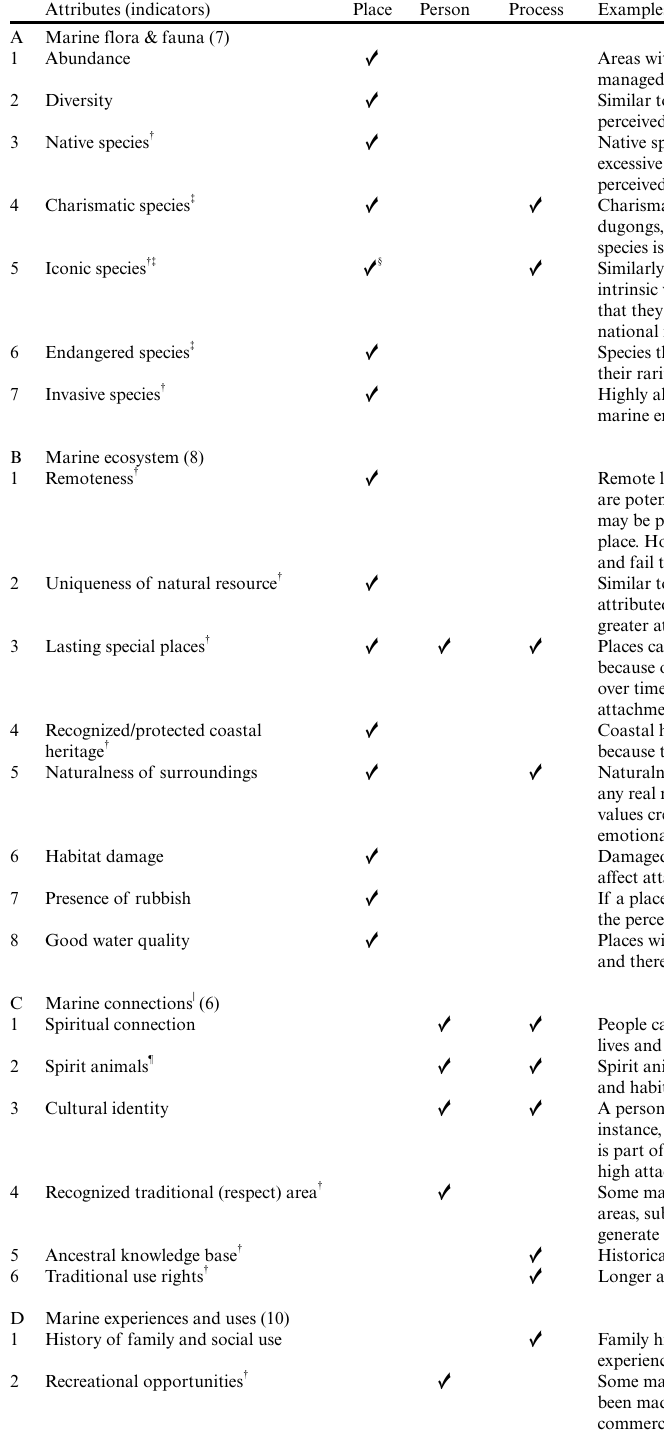
Table 1 . Categories (A to E) of 35 marine attributes (indicators) that contribute to place, person and process aspects of sense of place (SoP). This list is not exhaustive and attributes may have been missed in our attempt to summarise. Attributes (indicators) Place Person Process Examples of measurement of indicators or how the indicators should be